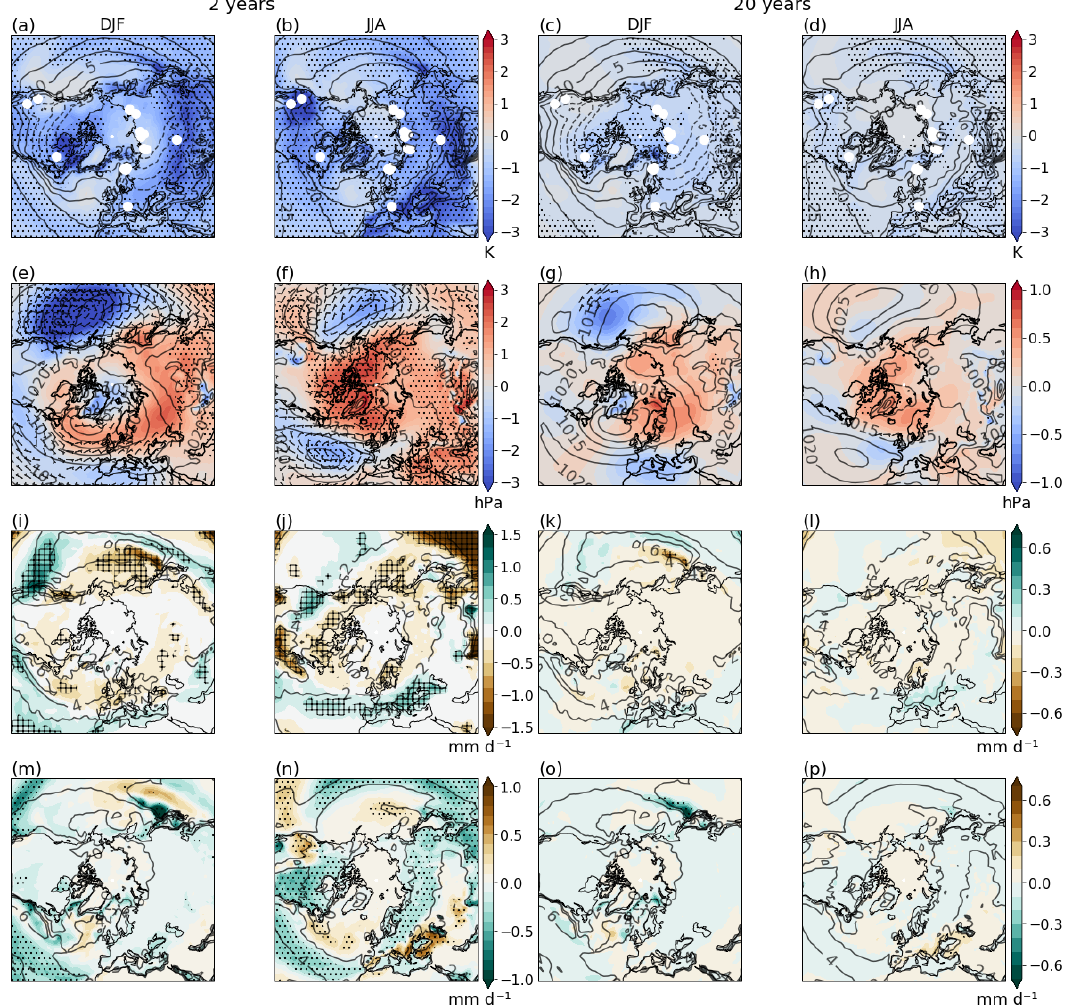
Figure 3. NH maps of boreal winter (DJF) and summer (JJA) 2m air temperature (a–d) , sea level pressure and 10m wind (e–h) , precipitation (i–l) , and evaporation (m–p) for 2 and 20 years after the eruptions poleward of 30 ◦ N. The maps represent the ensemble mean of the 2- and 20-year mean after the four major eruptions in the study period. The 2 years after the eruption are year 1 and year 2 after the eruption for DJF and the year of the eruption and 1 year after for JJA. All variables are given as anomalies with respect to 1–1850CE. The 1–1850CE climatology is given as contours, and the tree ring locations are represented by white dots in the 2m air temperature maps. The ensemble standard deviation 1 σ (2 σ ) for 2m air temperature, SLP, evaporation, and precipitation are hatched (stippled). Note the different scales for the 2- and 20-year maps and that wind anomalies are shown only for 0.5 and 1.0ms − 1